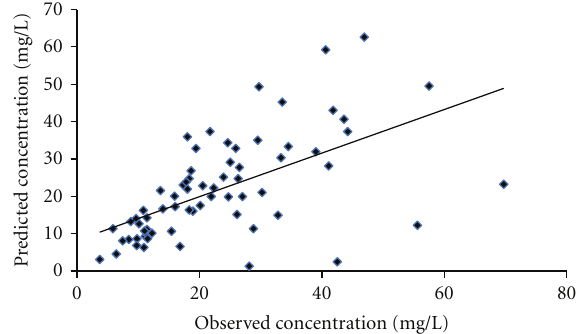
Figure 4: Scatter plot of observed against predicted concentrations of validation